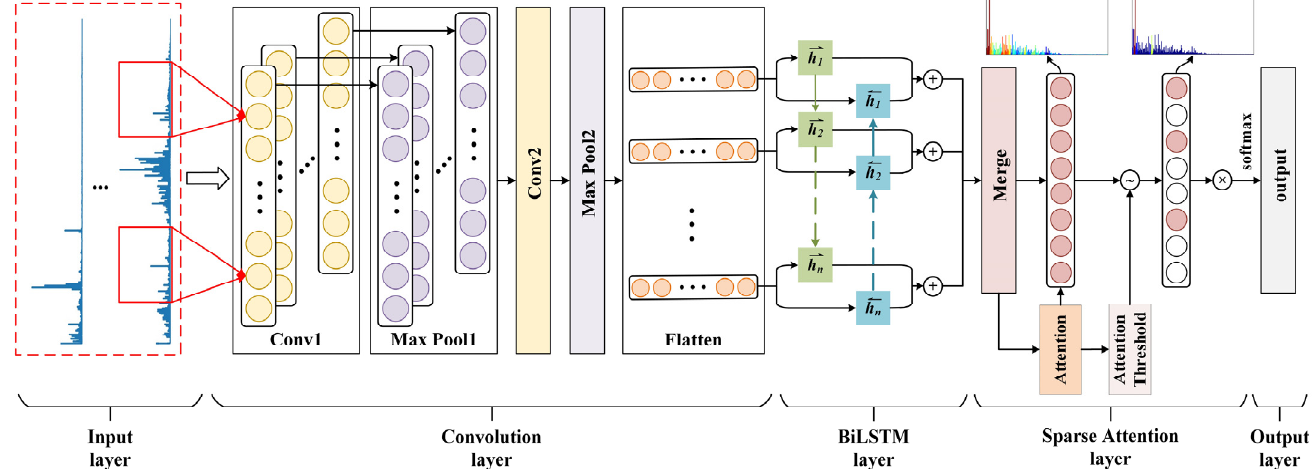
Figure 3. A deep learning architecture for fault diagnosis based on the adaptive sparse attention mechanism.